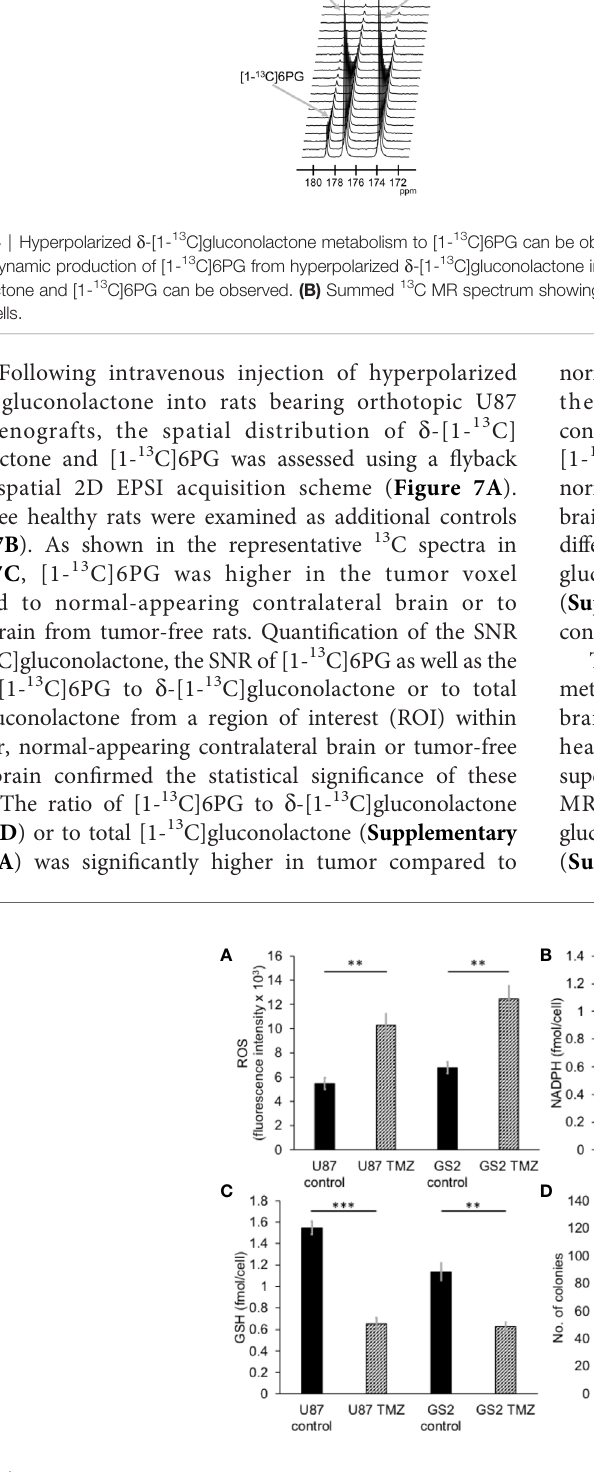
FIGURE 5 | TMZ induces oxidative stress and reduces proliferation in glioblastoma cells. Effect of TMZ on ROS (A) , NADPH (B) , GSH (C) and clonogenicity (D) in U87 and GS2 glioblastoma cells (n = 3 each). * indicates p < 0.05, ** indicates p < 0.01, *** indicates p < 0.001.